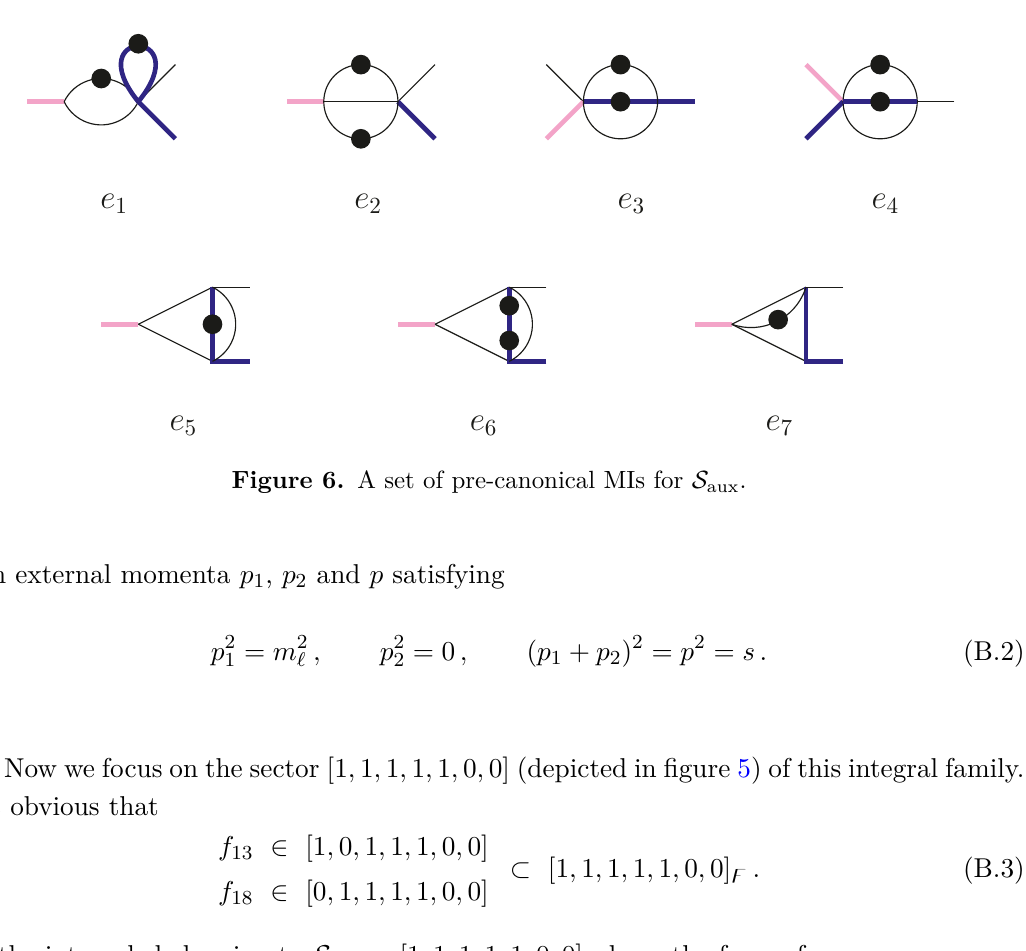
Figure 5. Sector [1 , 1 , 1 , 1 , 1 , 0 , 0] of the vertex integral family identified by eq. (B.1).